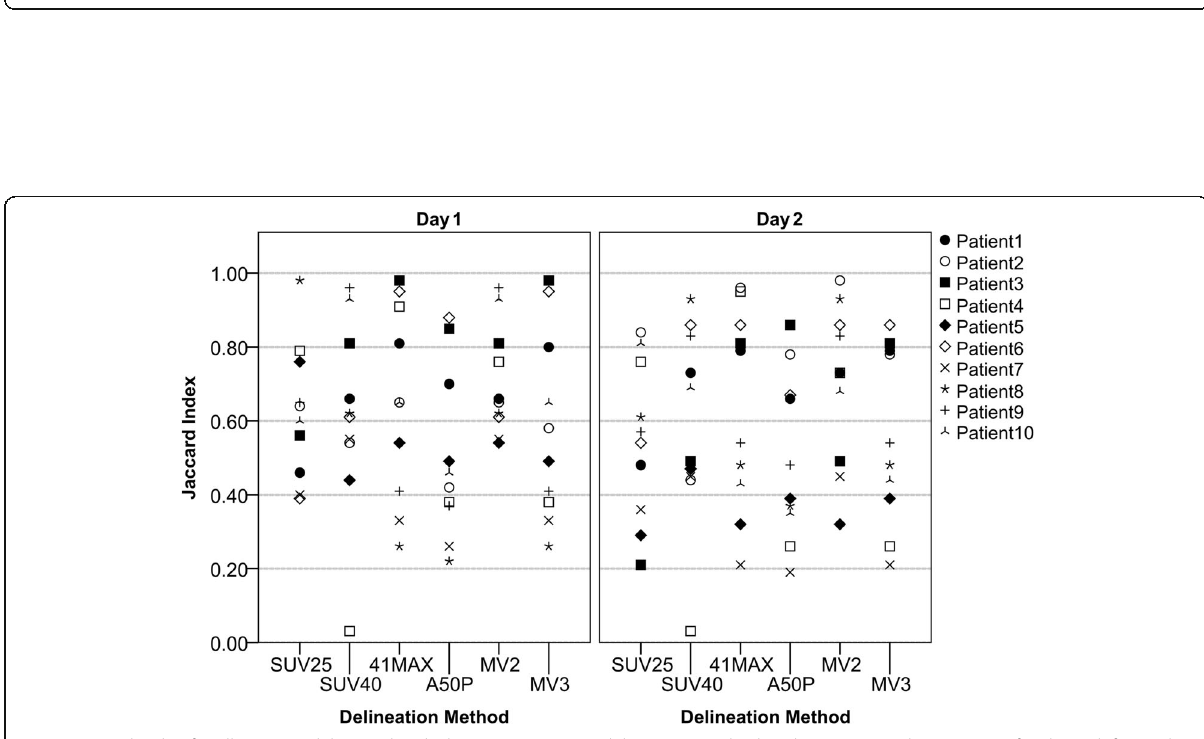
Fig. 2 Box plots with median and range of TMATV (mL). Y -axis in log-10 scale for better visualisation; outliers included. Panels on the left show the values acquired from EARL compliant reconstruction by the six semi-automatic delineation methods as well as the reference delineation (horizontal axis). On the right panels, data from images with PSF reconstruction. On the top row, data from the test (day 1 of scans) is displayed, while on the bottom row from retest (day 2 of scans). Data from scans acquired 60 or 90 min post-injection are colour-coded